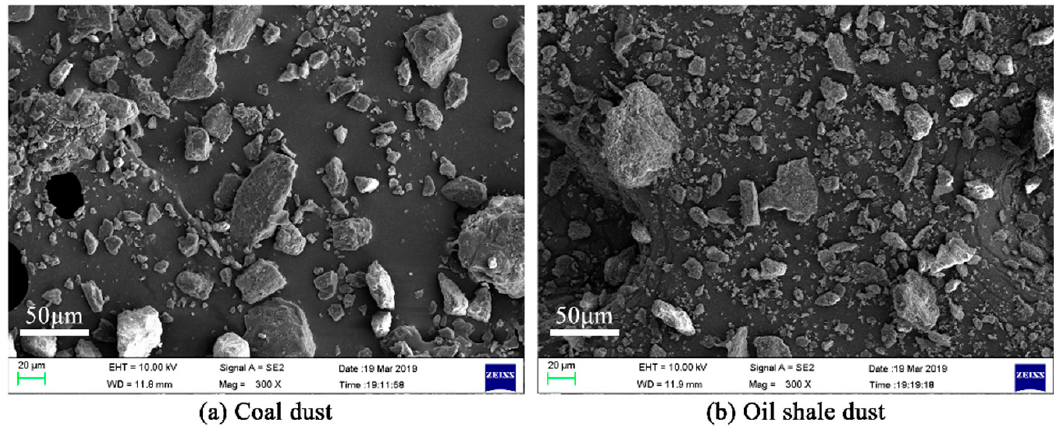
Figure 9. Scanning electron microscope (SEM) images of oil shale dust and coal dust before explosion: ( a ) coal dust; ( b ) oil shale dust.